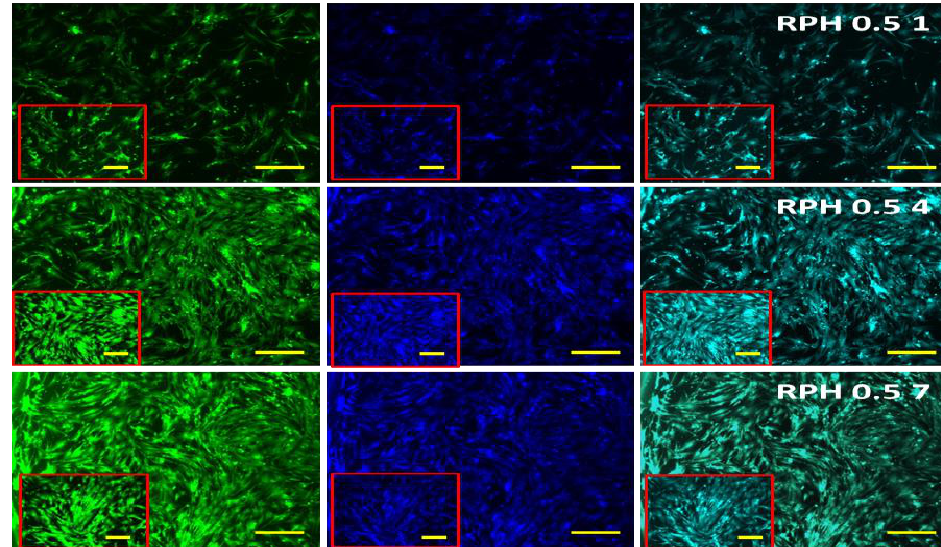
Figure 8. The FITC and DAPI fluorescence images of bone marrow mesenchymal stem cells cultured in RPHX hydrogels for 1, 4, and 7 days. Control cells treated without hydrogel, PVA solution 15 wt.%, RPH 0.1-0.1% retinol PVA, RPH 0.3-0.3% retinol PVA, RPH 0.5-0.5% retinol PVA. Scale bar 5 × –200 µ m, 10 × –100 µ m (Insert).